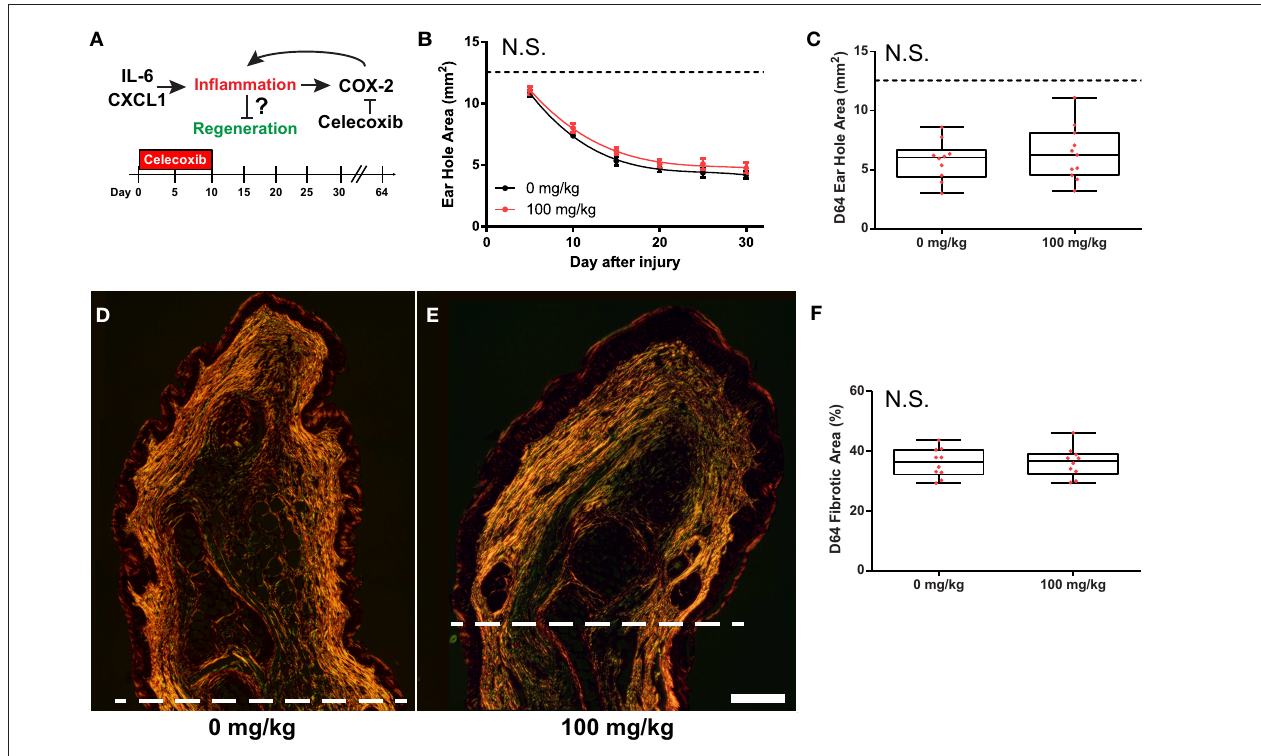
FIGURE 6 | COX-2 inhibition does not liberate regenerative response in M. musculus . (A) Celecoxib treatment during the first 10 days of injury reduces secondary inflammation caused by IL-6 and CXCL1. (B,C) Celecoxib treatment did not affect the rate of ear-hole closure from D5 to D30 (B) , or ear-hole area at D64 (C) . (D–F) Picrosirius stained, D64 ear tissue from control (D) and treatment (E) showed no difference in the total collagen scar area distal to the amputation plane (I) . Scale bar in (D,E) 250 µ M. Data represent mean S.E.M. and the lines represent cubic regression for n 10 per treatment (B) , OR individual data (red dots) and median and = ± = interquartile range for n 10 per treatment (C,F) =